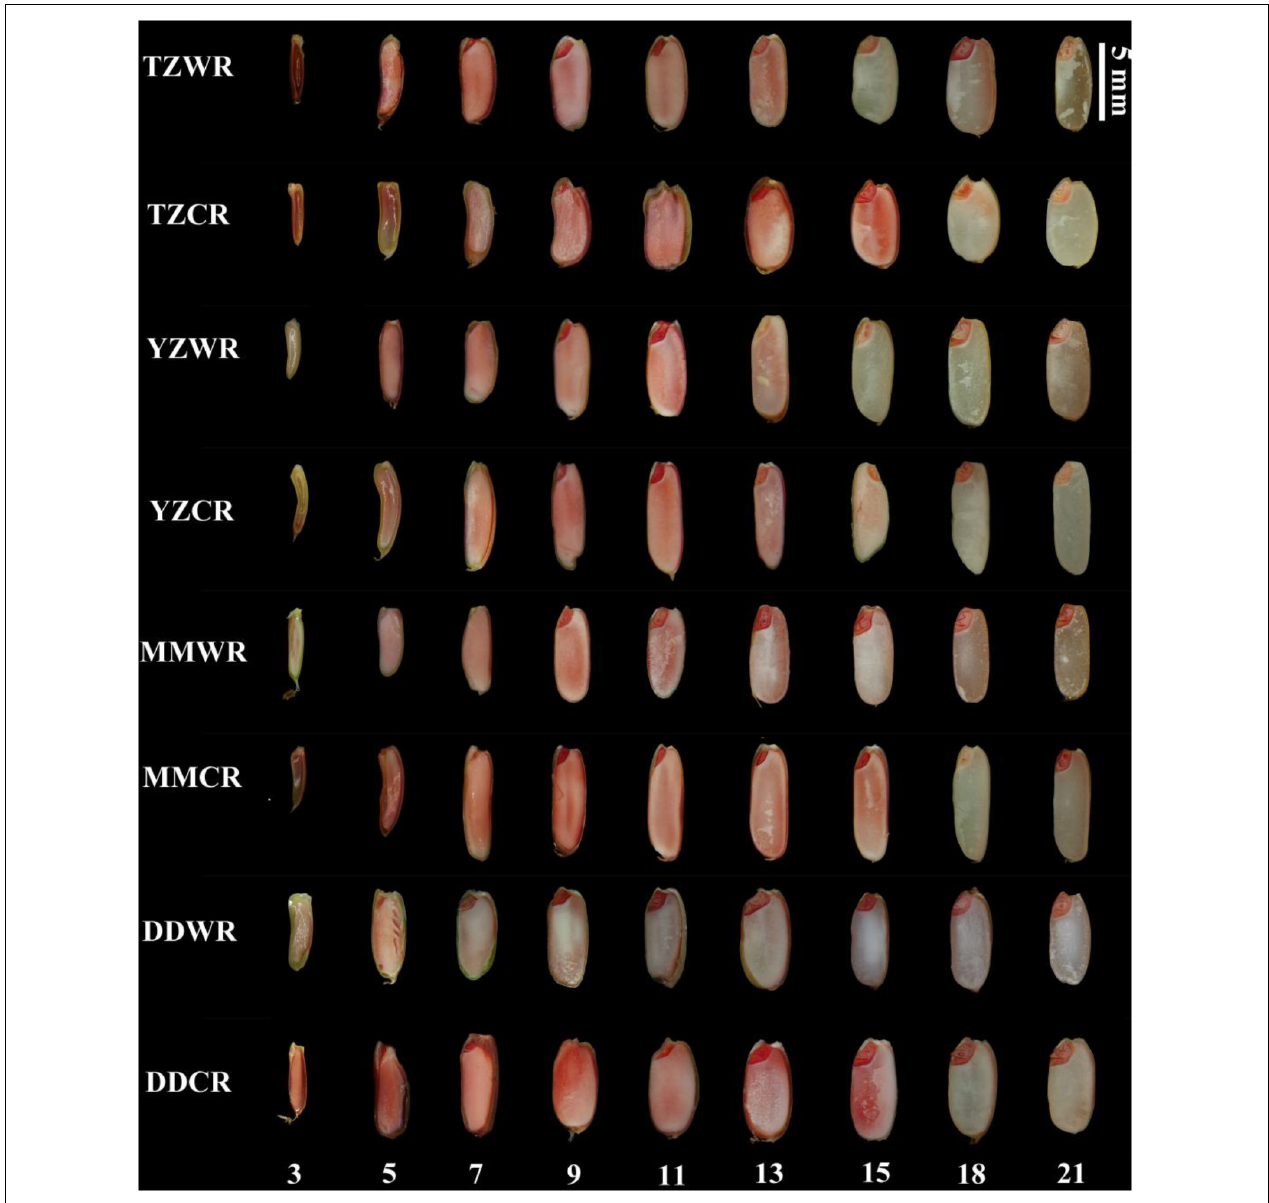
FIGURE 4 | 2,3,5-Tryphenyl tetrazolium chloride staining in developing grains of weedy and cultivated rice. TZWR, weedy rice from Taizhou; TZCR, cultivated rice from Taizhou; YZWR, weedy rice from Yangzhou; YZCR, cultivated rice from Yangzhou; MMWR, weedy rice from Maoming; MMCR, cultivated rice from Maoming; DDWR, weedy rice from Dandong; DDCR, cultivated rice from Dandong. The Roman numerals at the bottom of the picture represent the days post anthesis.